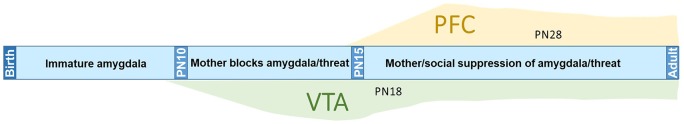
Developmental transitions in amygdala inputs regulating social suppression of threat. The neural circuit supporting infant fear learning and its maternal presence blockade (≤PN15) or attenuation (≥PN16) undergoes developmental changes. Social buffering in early infancy is supported by VTA-amygdala connectivity (≤PN15), while in older pups (PN28) and adults social attenuation of fear is supported by vmPFC-amygdala connectivity. This system is disrupted following early life abusive rearing. At PN18, the ability of the mother to block fear learning is abolished and VTA showed compromised suppression of the amygdala. Early life maltreatment leaves social suppression of fear learning intact at PN28, although it is effectiveness is reduced and social modulation of vmPFC engagement is significantly reduced.